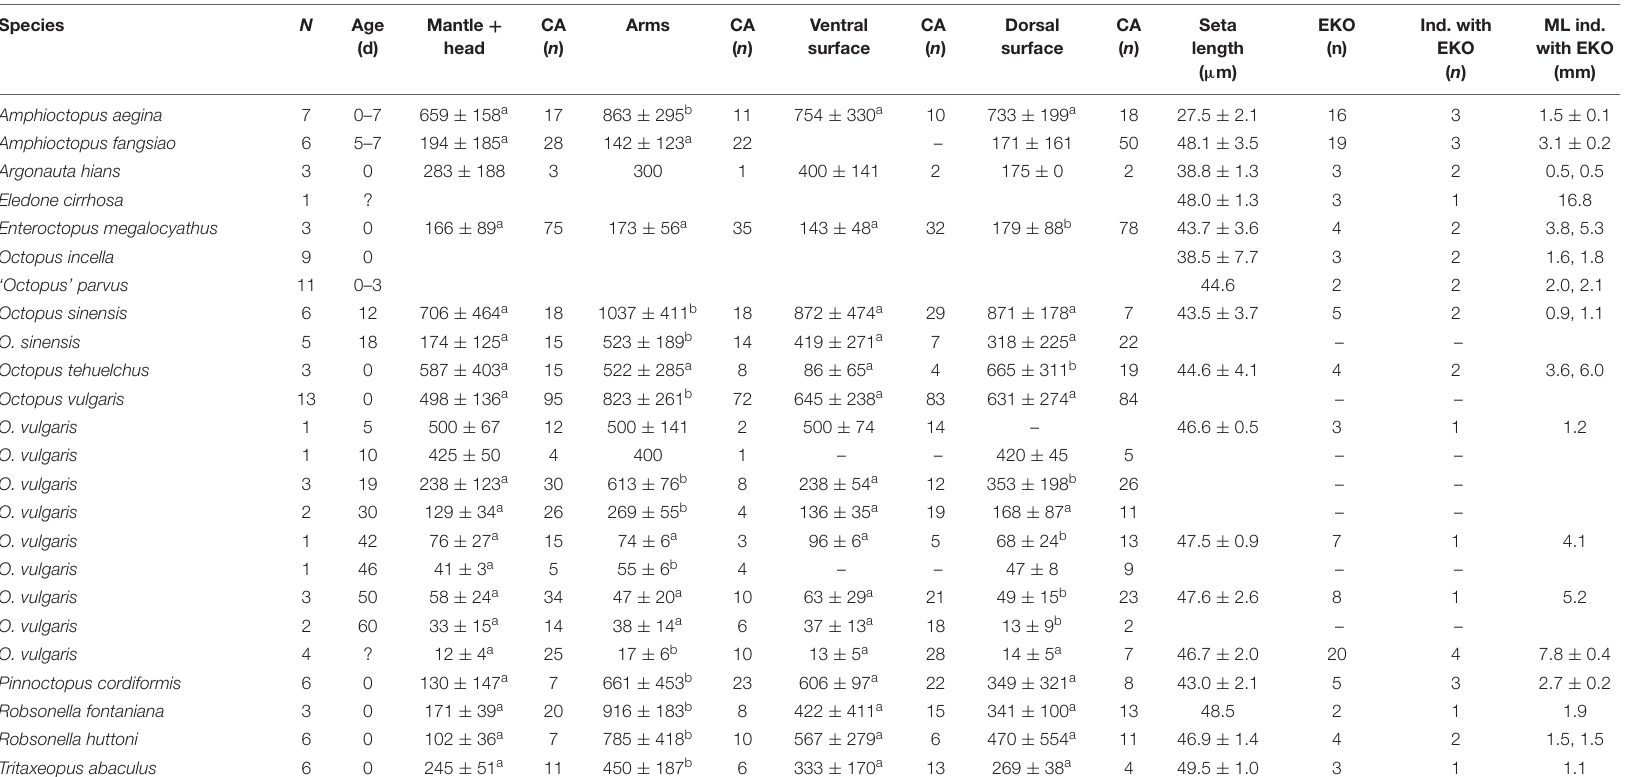
TABLE 3 | Kölliker’s organs (KO) density and seta length. Density (mean ± SD no. of KO per mm 2 ) on the mantle + head, arms and on the ventral and dorsal surface of the individuals are indicated. Species